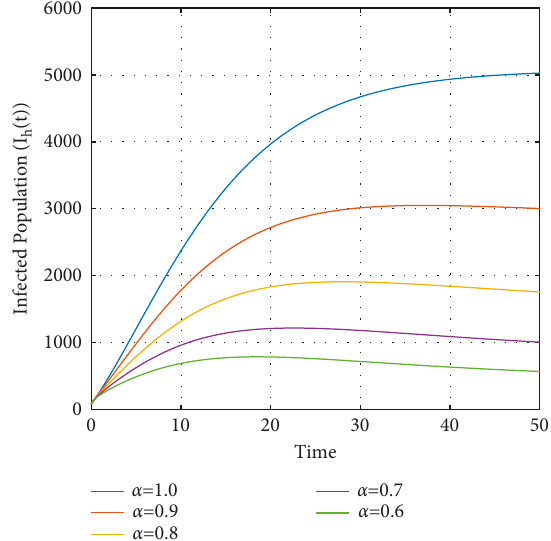
Figure 6: The graph represents the temporal dynamics of infected individuals against the fractional parameter ( σ ) and model pa- � 0 . 011, β � 0 . 005, ψ � 0 . 016, rameters value are: Λ � 0 . 4, β 1 2 � 0 . 01, d � 0 . 01 c � 0 . 05, c � 0 . 05, c � 0 . 05, d � 0 . 002, β 1 2 3 1 3 � 0 . 01, and η � 0 . 06, while the sizes of compartmental pop- η 1 2 ulation are ( 100 , 90 , 80 , 70 , 60 ) .